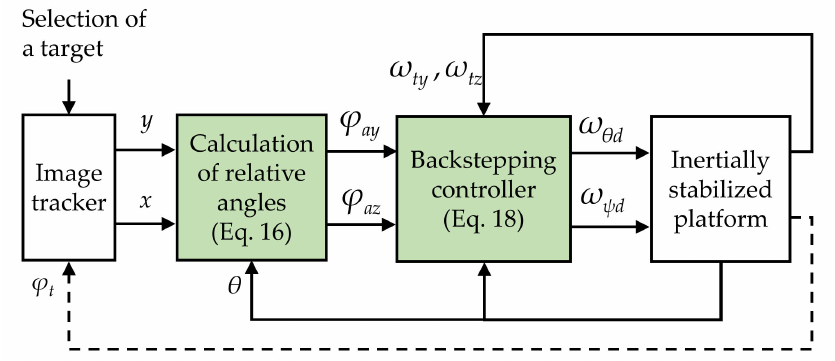
Figure 4. Schematic of the proposed